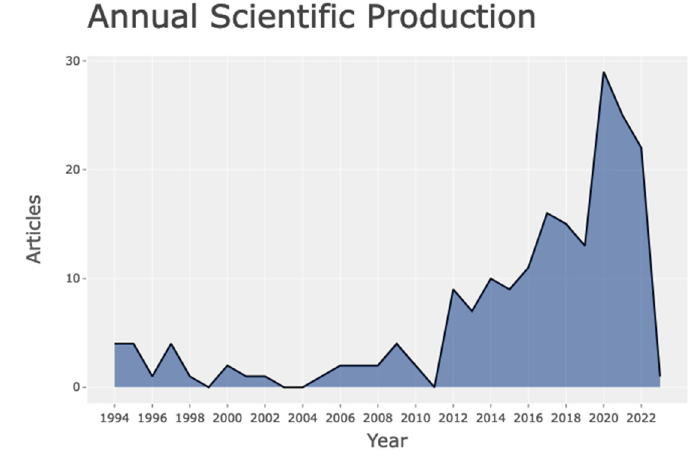
Figure 1. Annual scientific production.